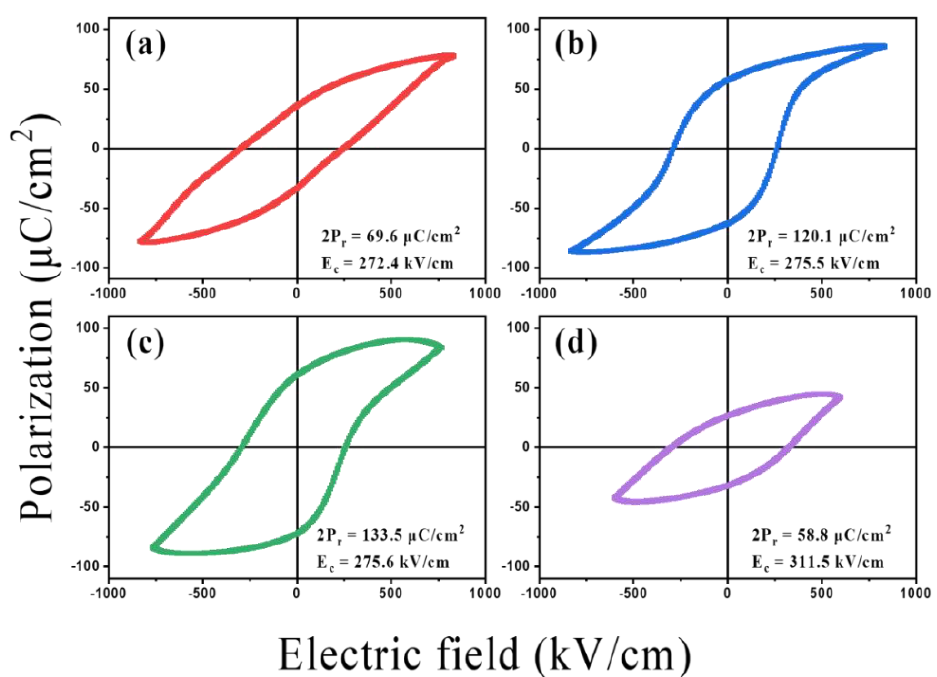
Figure 7. P - E curves of Bi 0.9 Gd 0.1 FeO 3 films: ( a ) T g = 350 °C, ( b ) 400 °C, ( c ) 450 °C, and ( d ) 500 °C. The curves of the leakage current density ( J ) versus the external electric field ( E ) of Bi 0.9 Gd 0.1 FeO 3 films at T g = 350 – 500 °C are shown in Figure 8. Low leakage, observed for BGFO at T g = 350 – 500 °C, contributes to good FE properties. The slight increase in leakage with increasing T g is presumably related to texture evolution, and the appearance of 2:4:9 phase at higher T g = 500 °C.